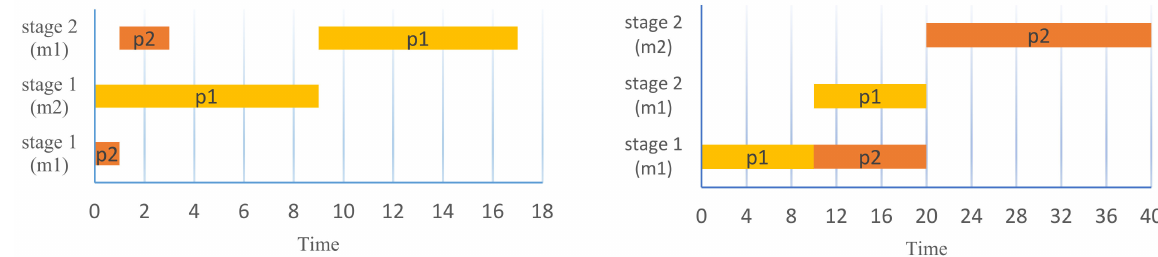
Figure 3. The completion time of Factory 1 ( left ) and Factory 2 ( right ) Gant chart.